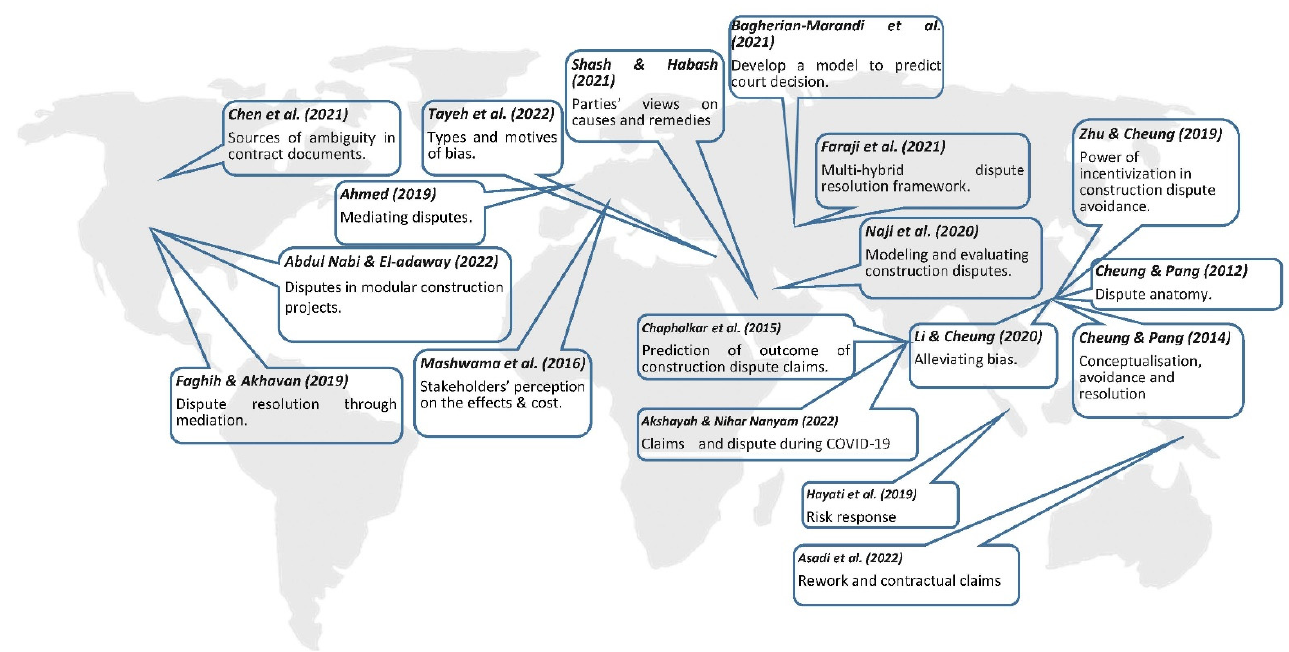
Figure 1. Construction dispute studies, subjects, and outcomes [46]. Table 2. Studies on construction dispute factors and categories.